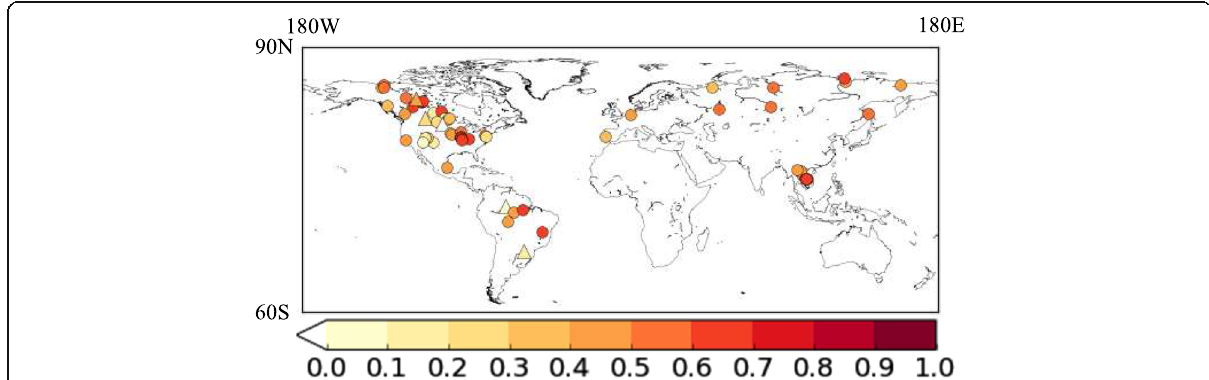
Fig. 4 Correlation coefficient of suspended sediment flow. Circles and triangles indicate significance and insignificance at the 95% level,